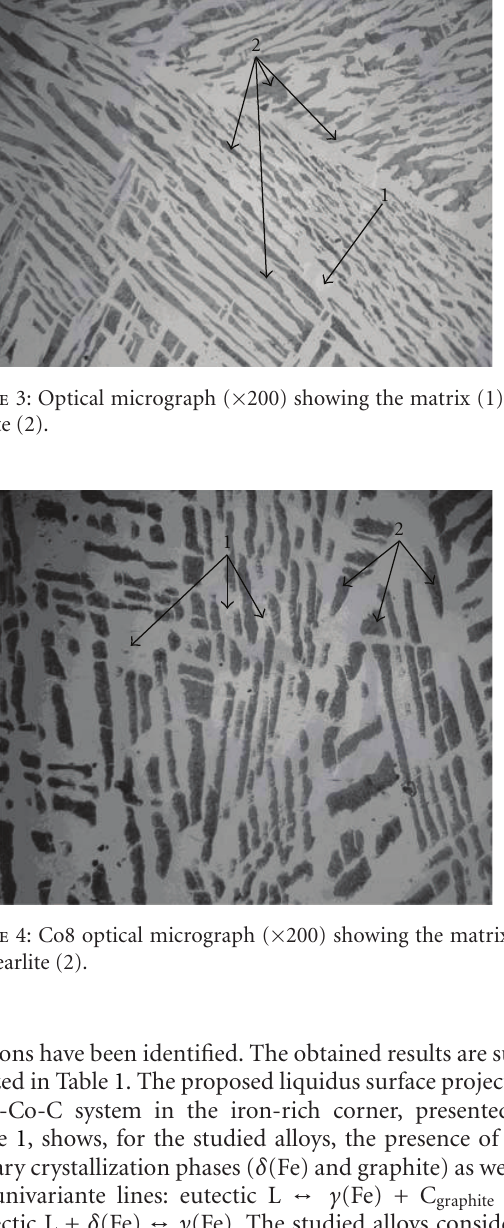
Figure 2: Potentiodynamic polarisation curves of Co2, Co3, Co6, and Co8 alloys in nondeaerated solution NaHCO 3 10 − 3 M + Na 2 SO 4 10 − 3 M, at 25 ◦ C.